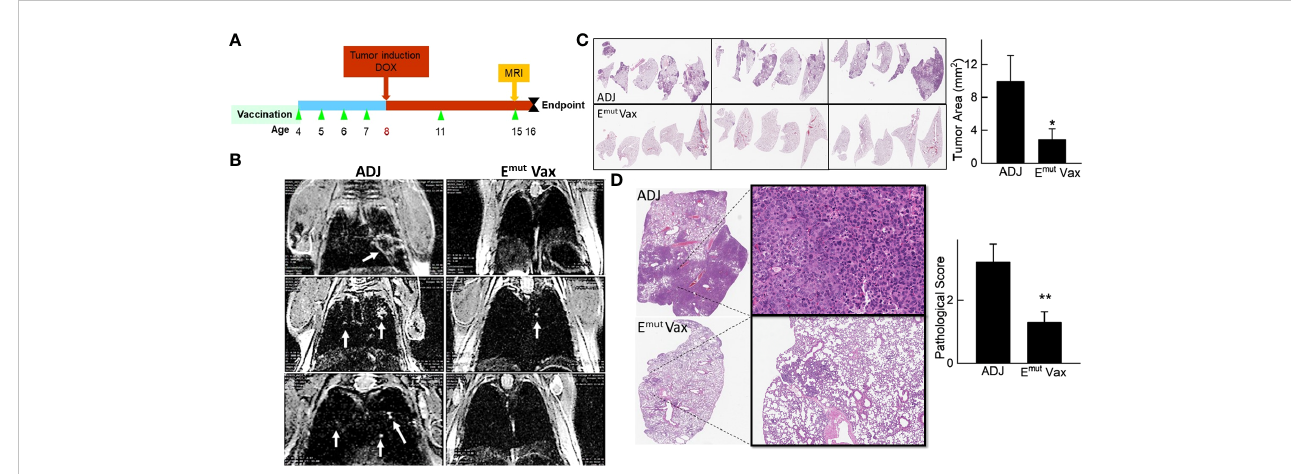
FIGURE 4 E mut Vax inhibits lung tumor progression in a genetically engineered mouse model. (A) Experimental design outlining the timing of vaccine administration and tumor induction with DOX diet, the time point for MRI monitoring, and the experimental endpoint. (B) Representative MRI images from mice injected with either adjuvant control or E mut Vax. (C) Representative lung lobes (left panel) and quanti fi cation of tumors (right panel) from each group. (D) Representative lung lobes (left panel) and pathological scores (right panel) from each group. Data are shown as the mean ± SE, n=10, *P ≤ 0.05, **P ≤